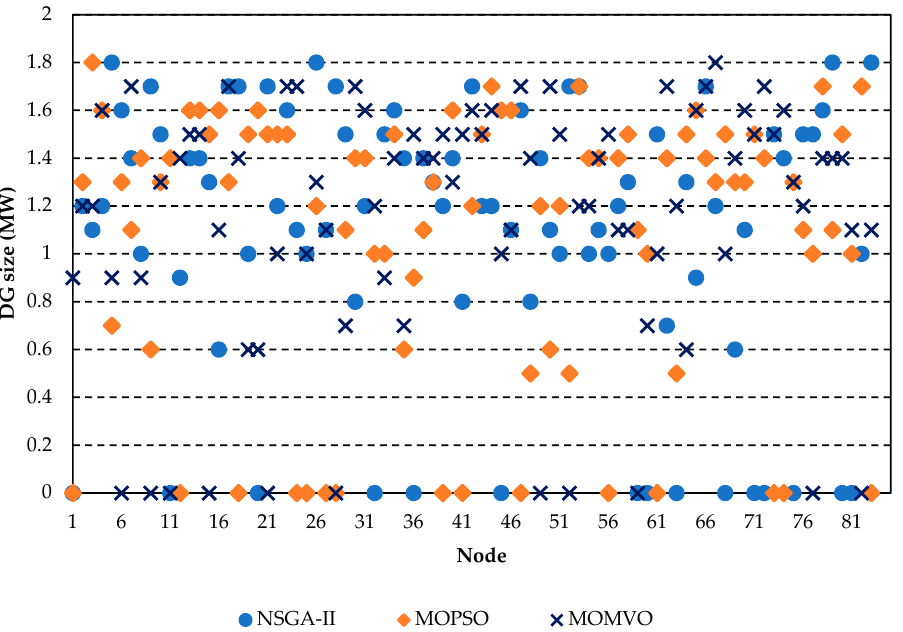
Figure 13. DG sizes at each node: 83-node distribution system.